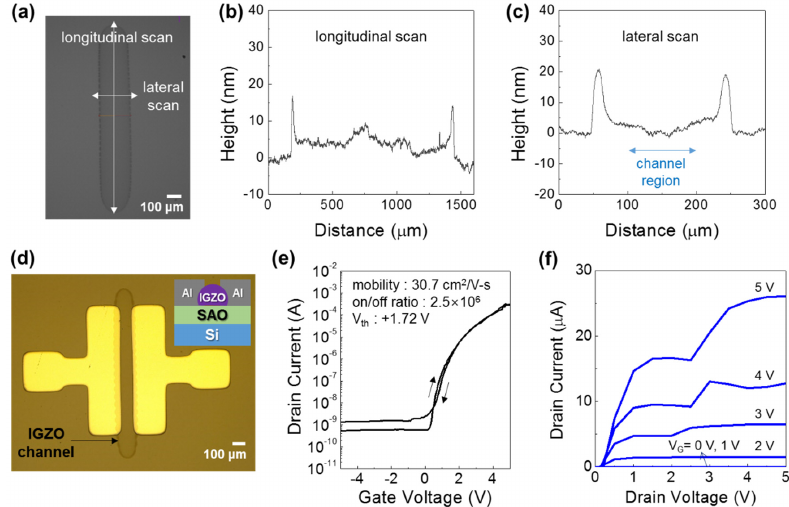
Figure 4. ( a ) An optical image of inkjet-printed IGZO channel layer with linear-type drop pattern. Thickness profiles of an inkjet-printed IGZO channel layer, ( b ) longitudinal scan, and ( c ) lateral scan. ( d ) An optical image, ( e ) transfer characteristics, and ( f ) output characteristics of an inkjet-printed IGZO TFT with linear-type pattern.